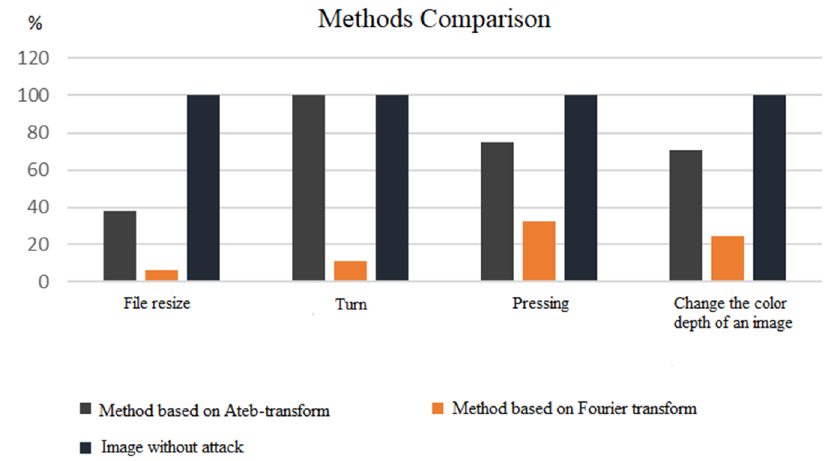
Figure 2. Comparison of the stability of methods for embedding a digital watermark in relation to attacks.